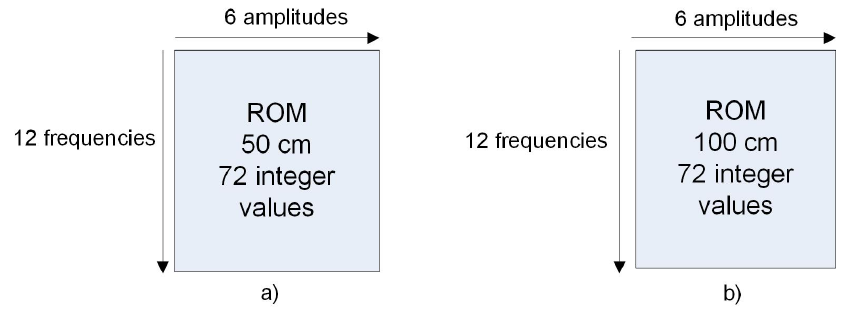
Figure 10. Storage of LED lighting times. ROMs with 144 values (72 each) for the SPCS and SSAC tests for ( a ) 50 cm and ( b ) 100